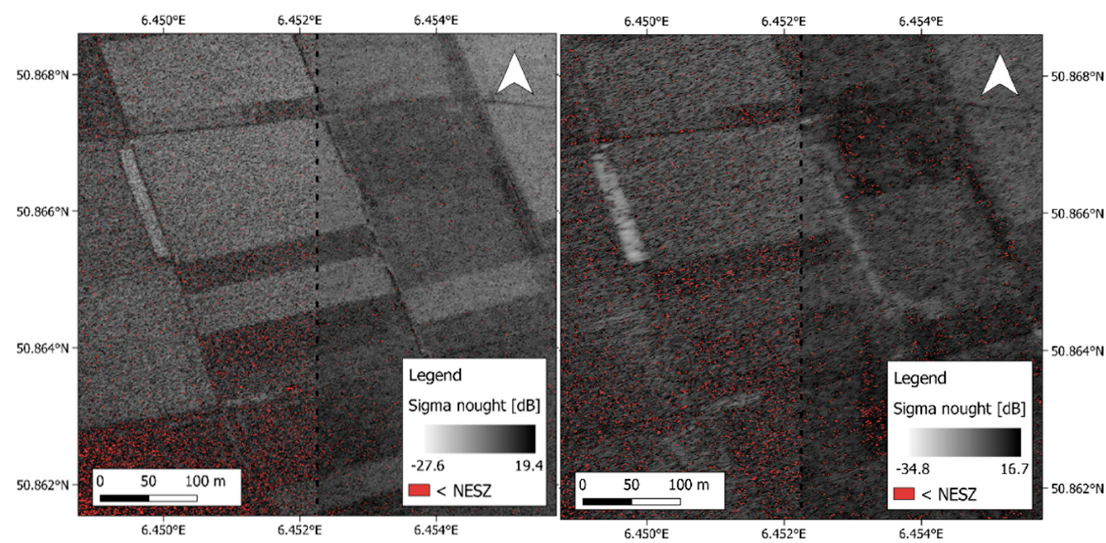
Figure 7. Comparison between unfiltered and speckle filtered SAR image for C-band (left) and L-band (right) for HH polarization from 19 June.